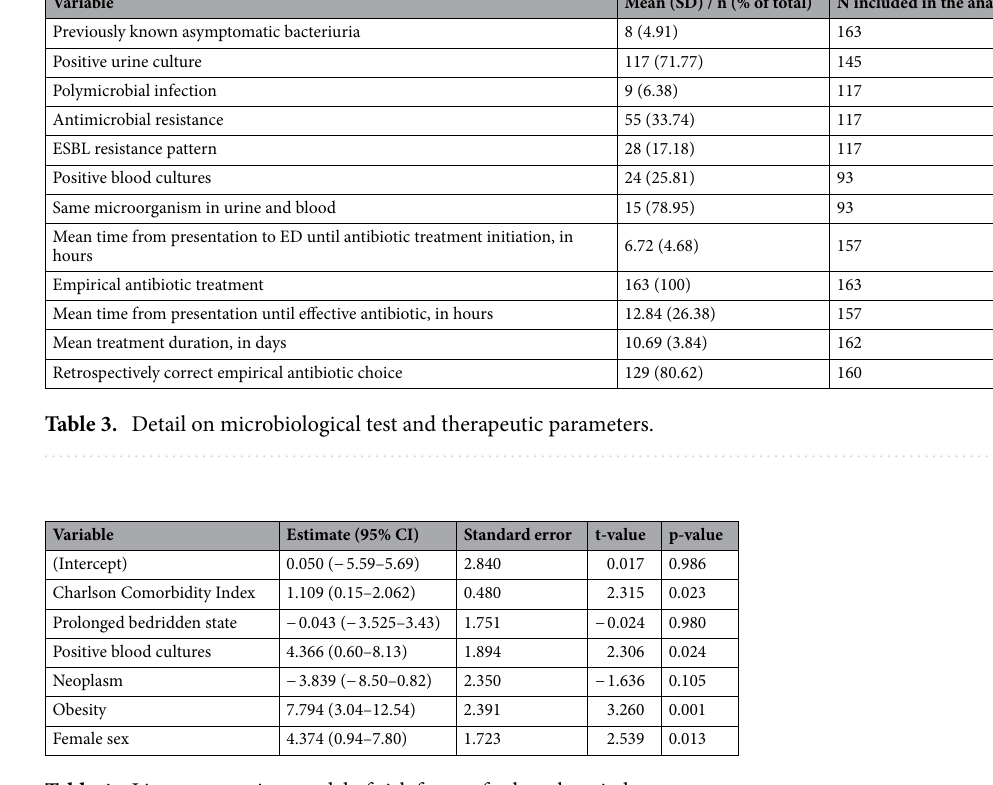
Table 4. Linear regression model of risk factors for long hospital stay.